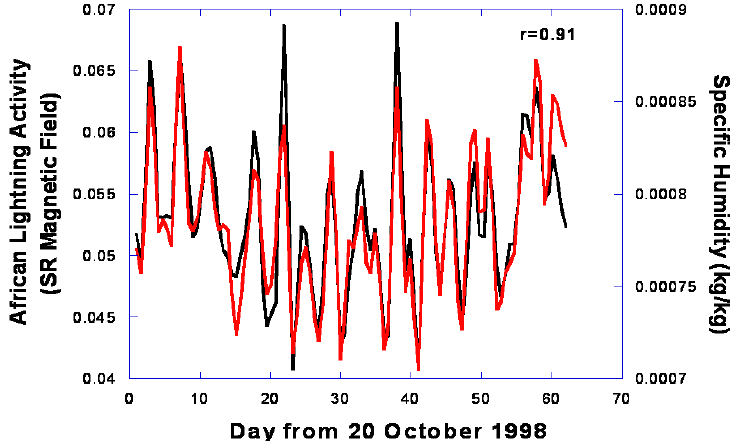
Figure 9. Daily SR 8 Hz magnetic field (at 14 UT H ew ) records (black) and upper tropospheric water vapor (red) over tropical Africa [100].